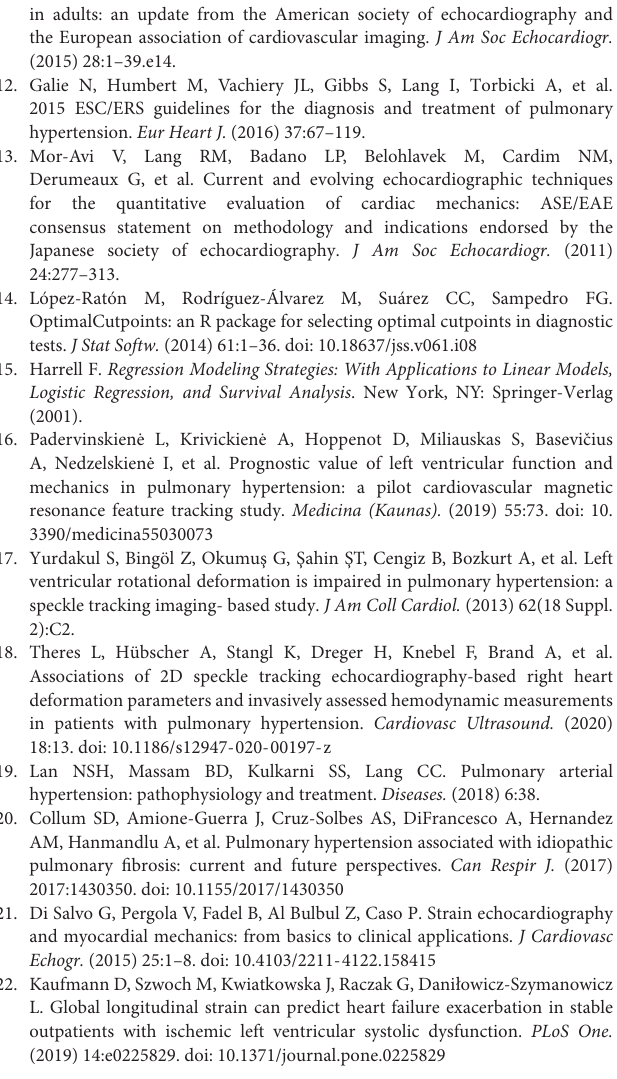
Supplementary Figure 1 | Algorithm for patients’ selection. Supplementary Figure 2 | Correlation of RV-Fibrosis (A) and RA-Fibrosis (B) with sPAP. sPAP, systolic pulmonary arterial pressure; RV-FWS, right ventricular free wall strain; RA-GS, right atrial global longitudinal strain. Supplementary Figure 3 | Correlation of sPAP using echocardiographic and right heart catheterization (A) and Bland–Altman plot with observed differences between both the methods of measured sPAP (B) . sPAP, systolic pulmonary arterial